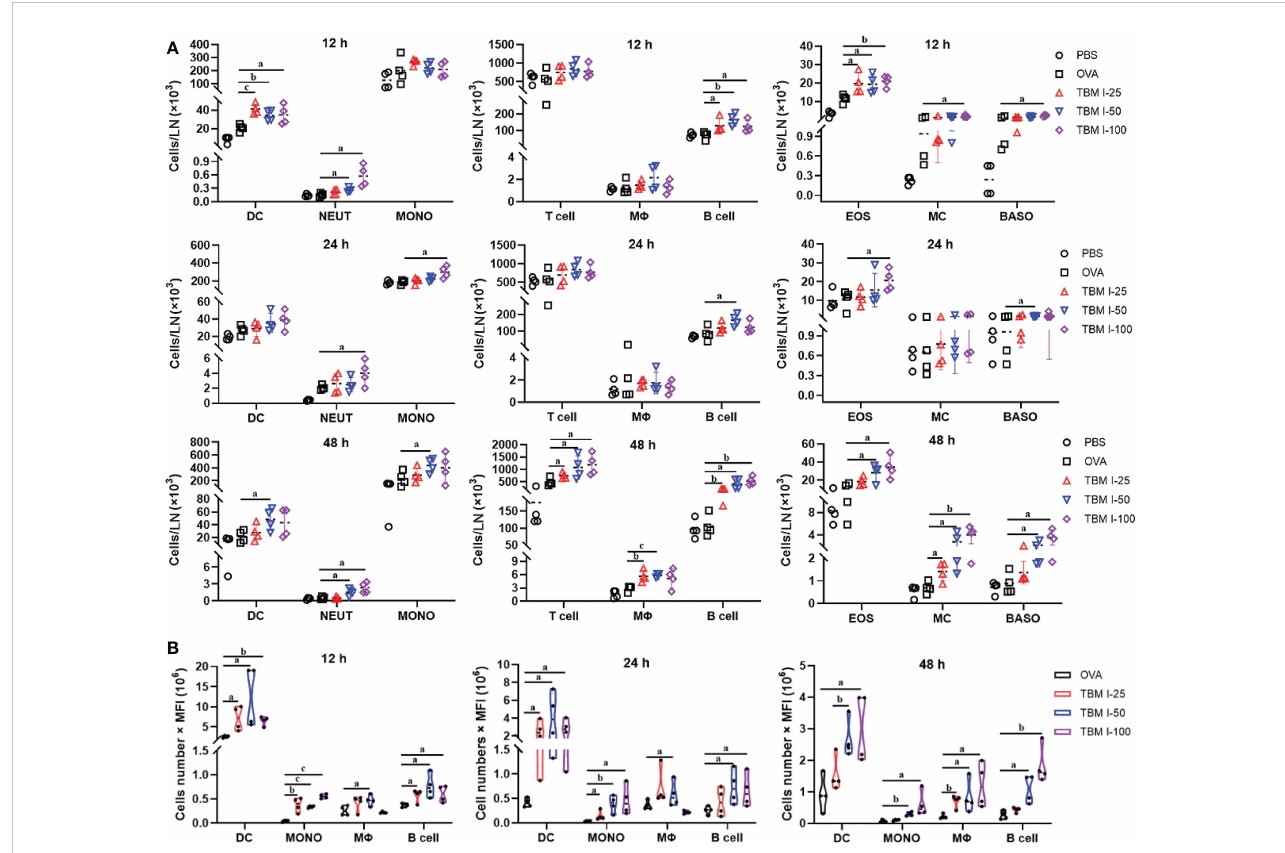
FIGURE 6 TBM I induced the migration of immune cells and antigen transport to dLNs. Mice were injected i.m . with OVA-AF488 alone or adjuvanted with TBM (I) The inguinal lymph nodes were collected at the indicated time point and subjected to FCM. (A) The number of immune cells migrated to dLNs at 12, 24, and 48 hpi. (B) The antigen ingestion of DCs, monocytes, macrophages, and B cells in dLNs at 12, 24, and 48 hpi by cell numbers × MFI. The data are presented as mean ± SD ( n = 4). a P < 0.05, b P < 0.01, and c P < 0.001 vs OVA-AF488. DC, dendritic cell; NEUT, neutrophil; MONO, monocyte; M F , macrophage; EOS, eosinophil; MC, mast cell; BASO,